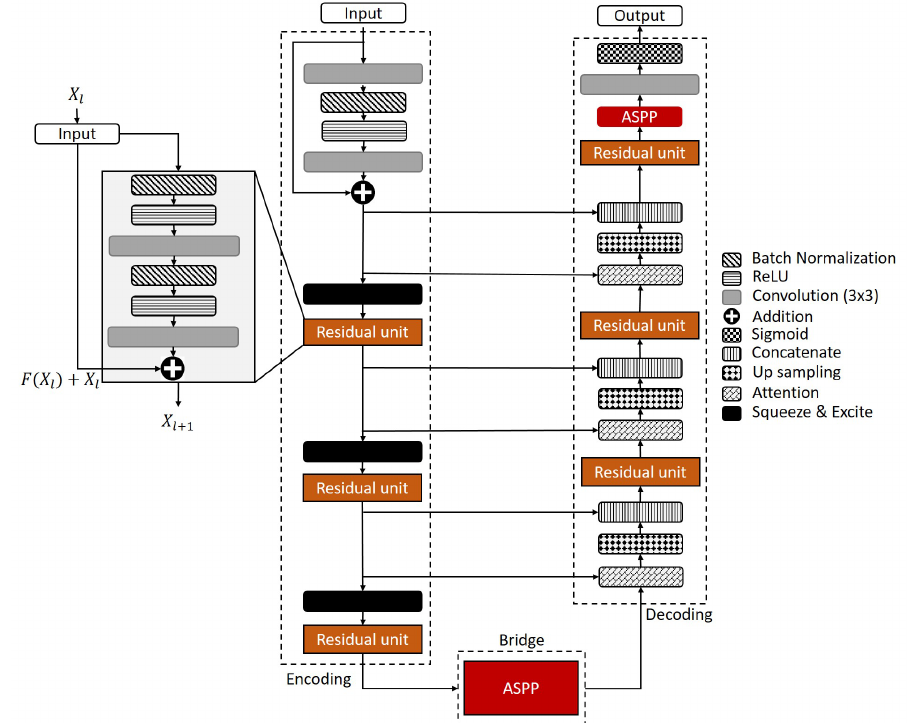
Figure 6. Architecture of